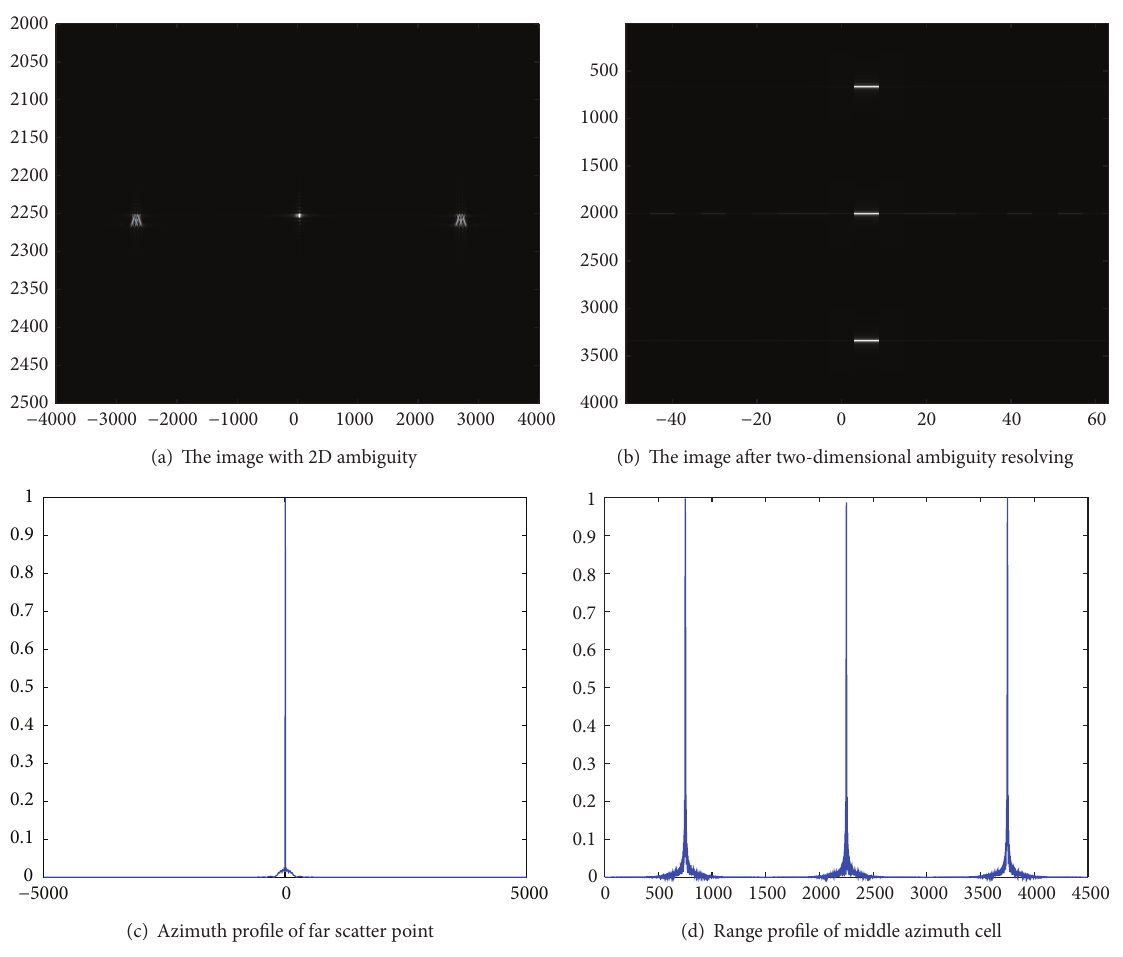
(b) The image after two-dimensional ambiguity resolving